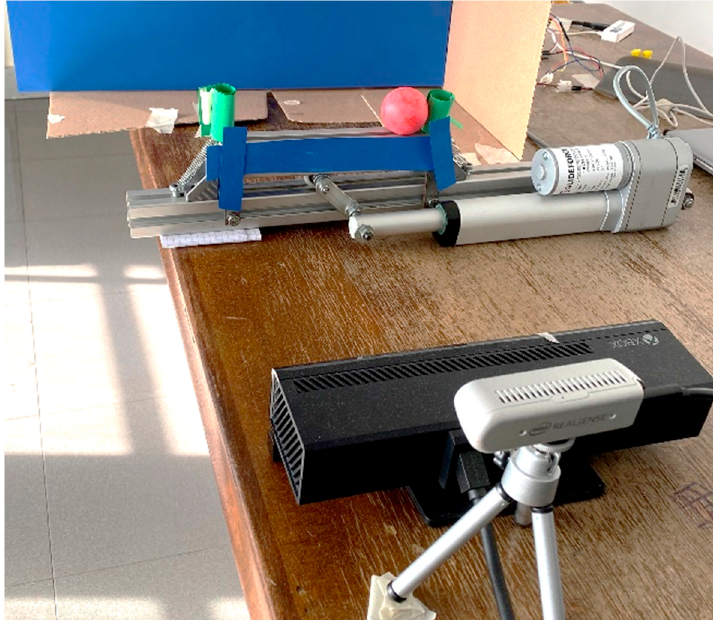
Figure 11. Experimental apparatus with a slide moved by the linear actuator for the ball equilib- rium application.